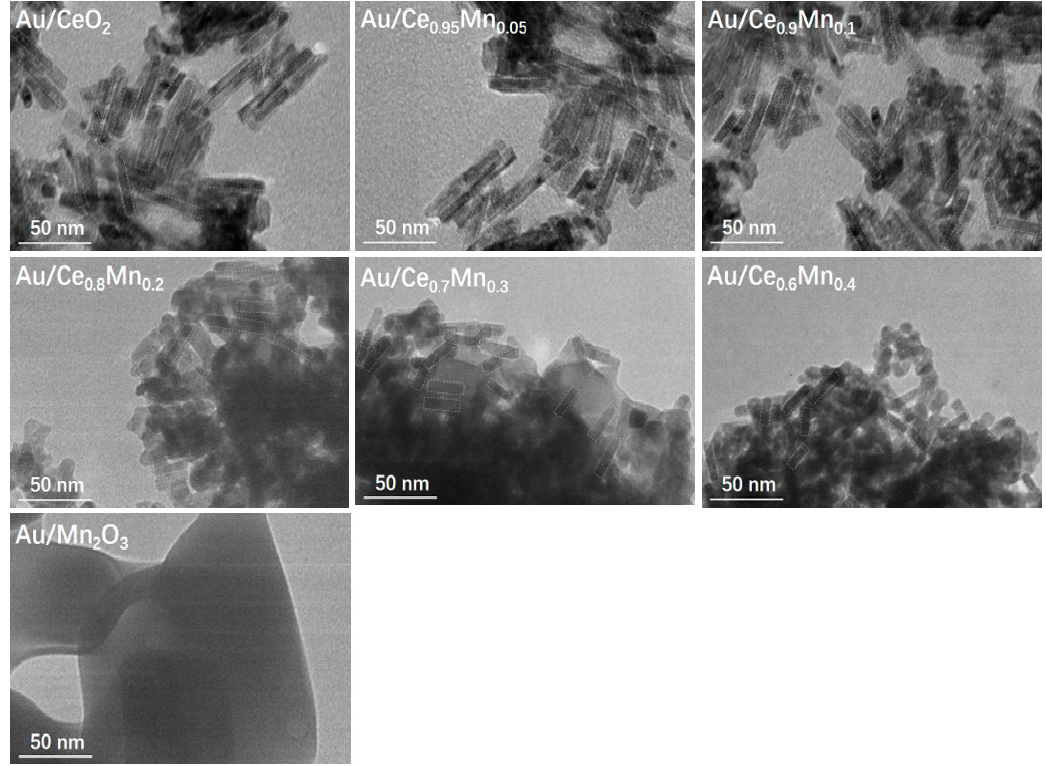
Figure 2. TEM images of the Au/Ce 1 − x Mn x O 2 − δ catalysts with different Mn/Ce ratios. Textural properties of the catalysts are obtained via N 2 adsorption, and the results are shown in Table 1. The specific surface areas of the CeO 2 ‐ based catalysts changed little after the Mn ‐ doping. Table 1. Textural and structural properties of the Au/Ce 1 − x Mn x O 2 − δ samples.